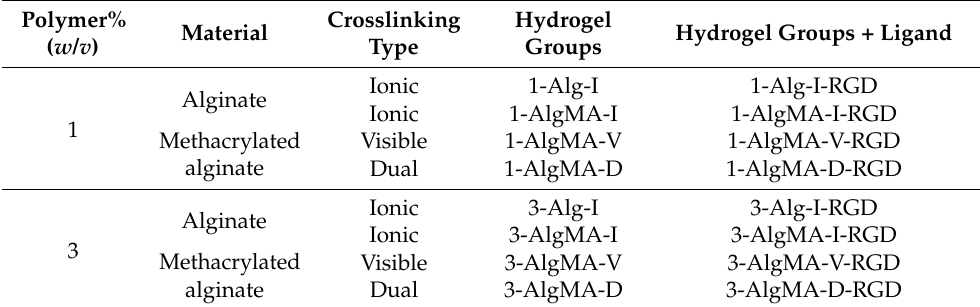
Table 1. Hydrogel scaffold groups comprising alginate in its non-modified (Alg) and chemically modified (AlgMA) forms. The material groups selected for this study differed with regard to polymer concentration, the method of crosslinking, and cell adhesion ligand conjugation (i.e., RGD). Material group labels are identified in the far-right